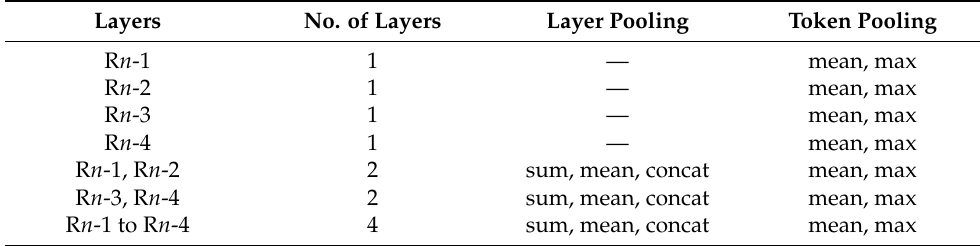
Table 1. Strategy to generate sentence embeddings from each region (ref. Figure 1) of the BERT model. R n - i represents the i th layer in the n th region. We combine each layer pooling strategy with every token pooling strategy across identified layers to generate multiple sentence embeddings. Layer pooling is not applicable for the sentence embeddings generated using a single vector. Layers No. of